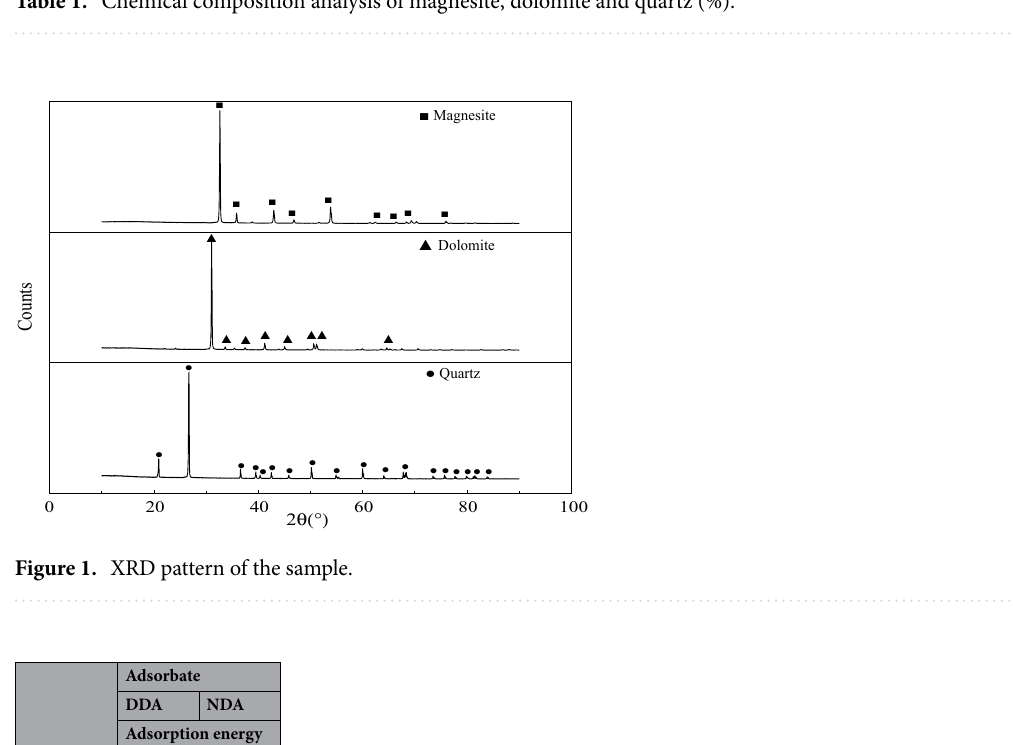
Table 1. Chemical composition analysis of magnesite, dolomite and quartz (%).